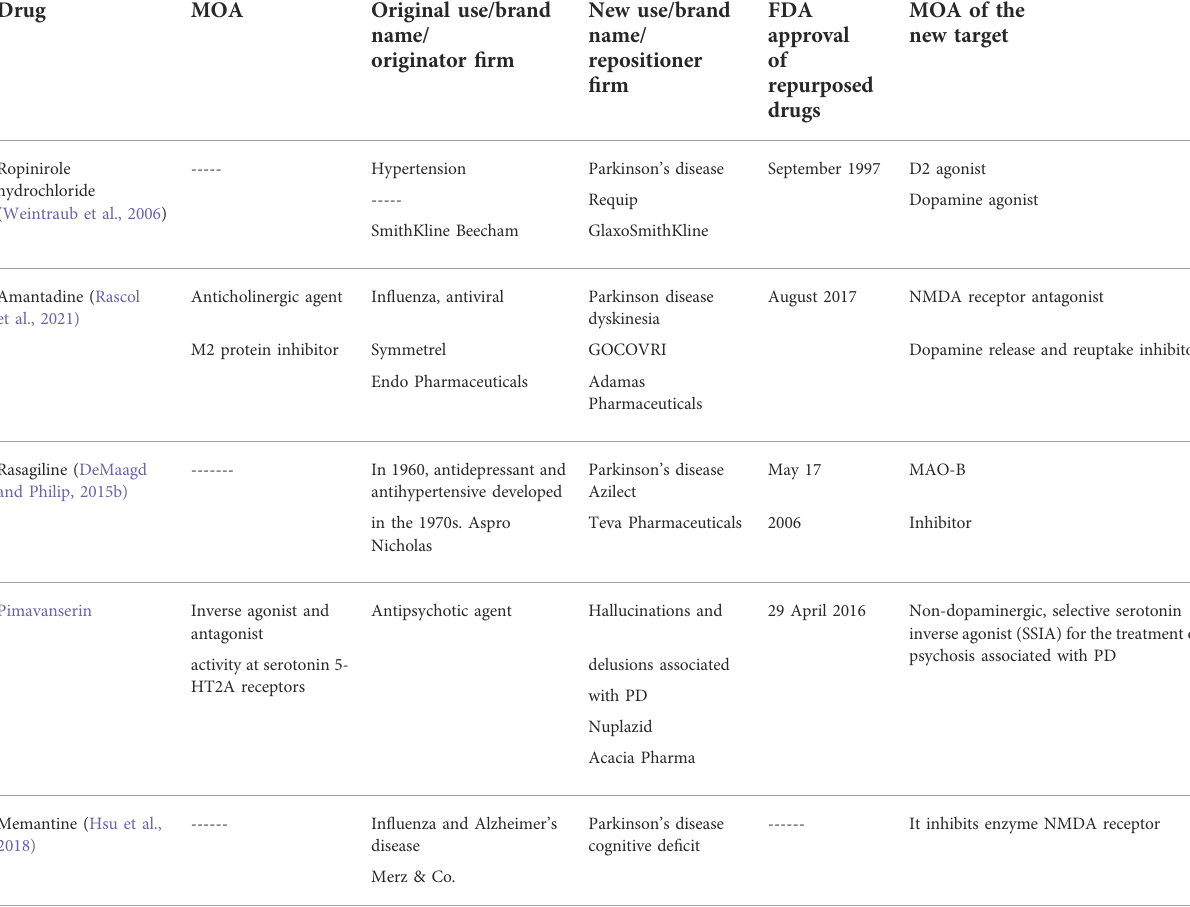
TABLE 3 Repurposed drugs reported in the literature with FDA-approved status for the treatment of Parkinson ’ s